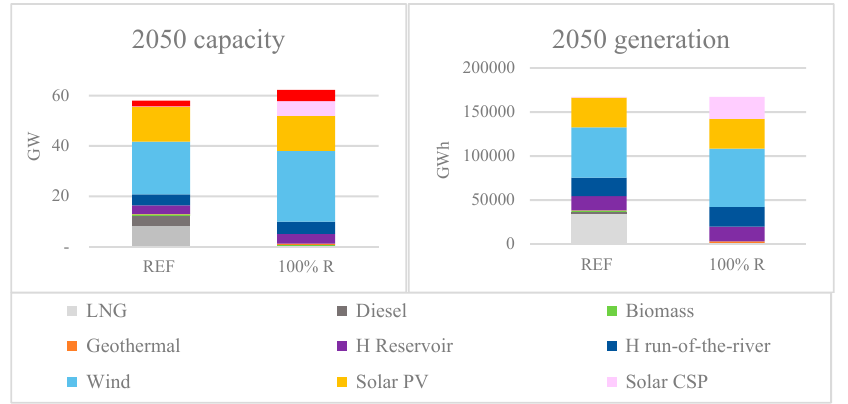
Figure 5. Capacity and generation in 2050 of the reference and 100% renewable scenarios.